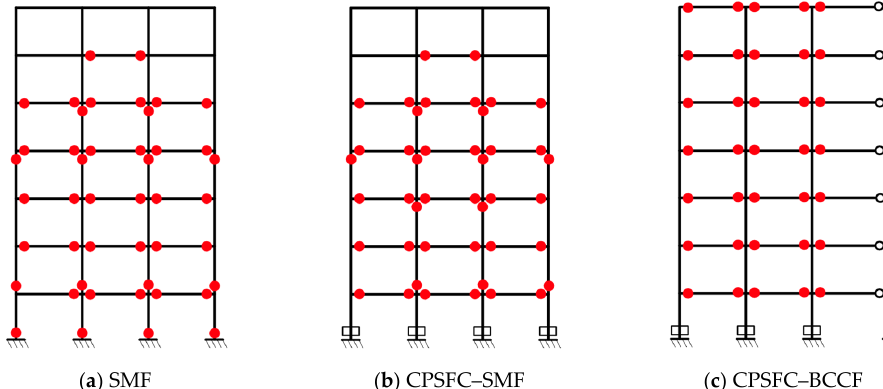
Figure 17. Plasticity hinges’ condition.